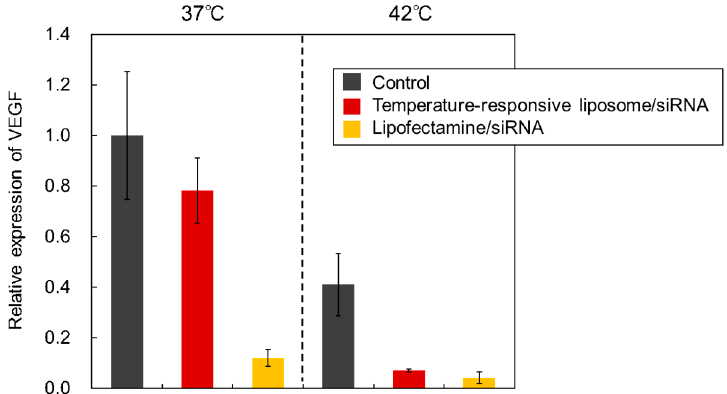
Figure 10. VEGF gene silencing using liposome-siRNA complexes in HeLa cells. Cells were treated with complexes for 4 h at 37 °C or 42 °C followed by incubation for 44 h at 37 °C. VEGF mRNA levels were estimated by real time-PCR normalized to β -actin mRNA. The relative expression of VEGF was estimated by the VEGF expression level of HeLa cells at 37 °C as a control. The error bars indicate the range of the relative expression of VEGF using real time PCR. The dotted line indicates the difference in incubation temperature.